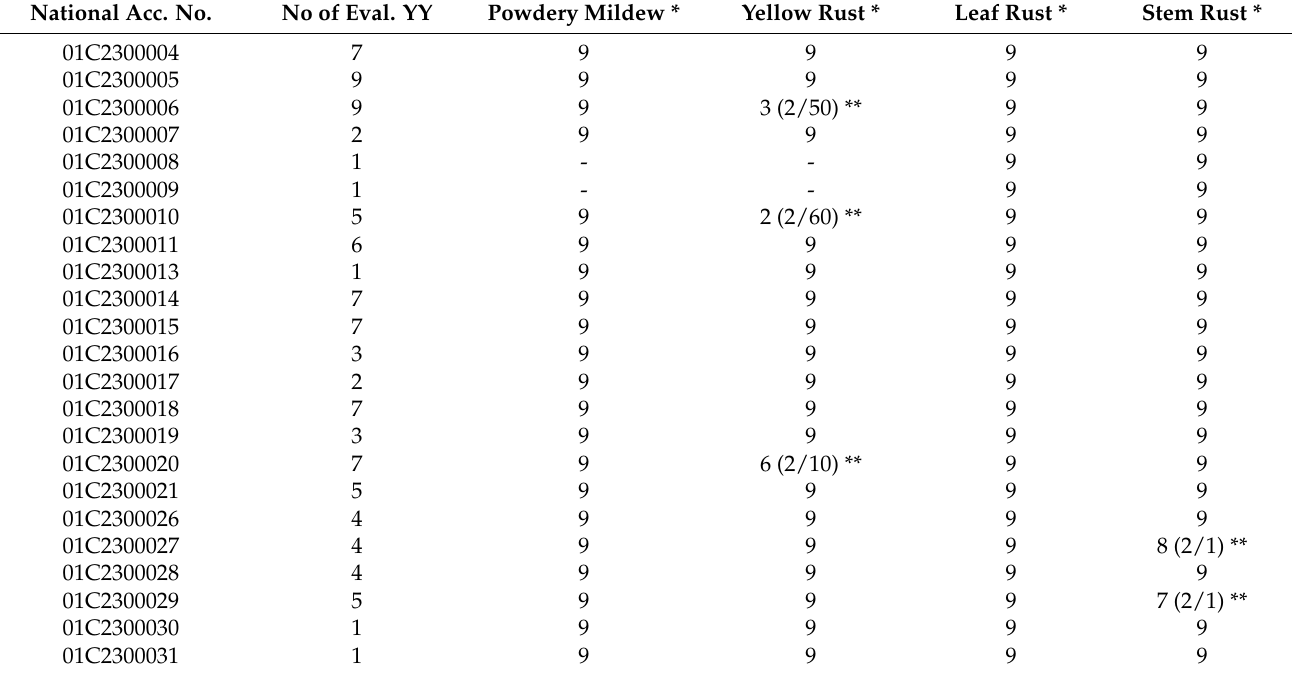
Table 2. Field resistance of Dasypyrum villosum accessions to powdery mildew, yellow, leaf and stem rusts. The worst score during the evaluation years. National Acc. No. No of Eval.